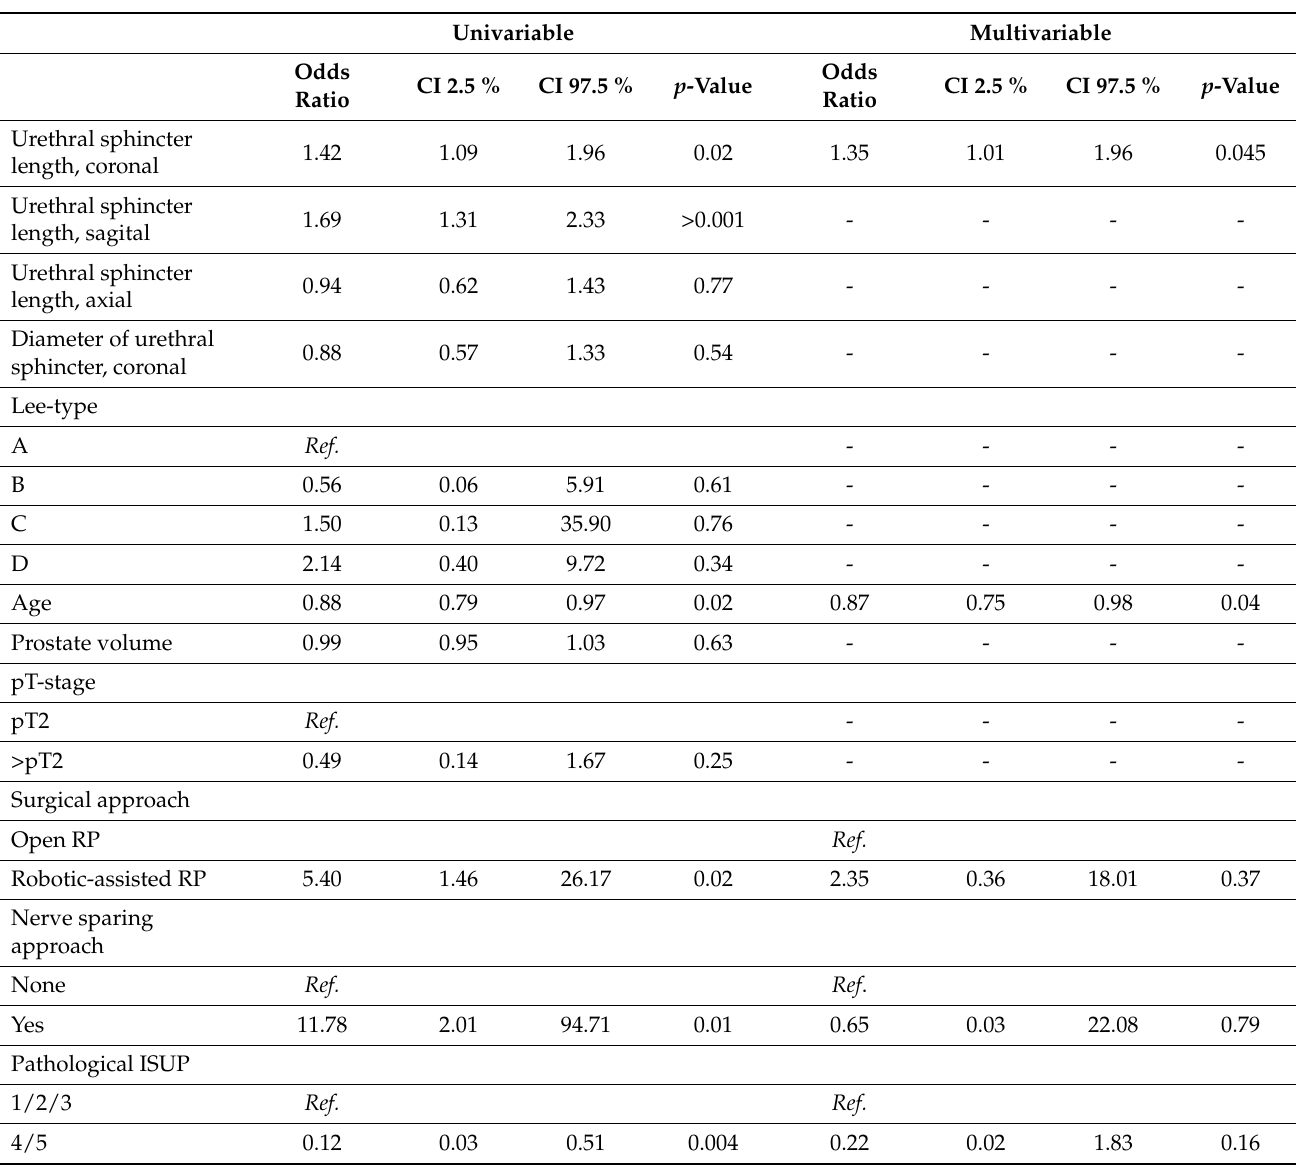
Table 4. Univariable and multivariable logistic regression models predicting urinary continence at medium follow-up following radical prostatectomy, defined as none or one safety pad per 24